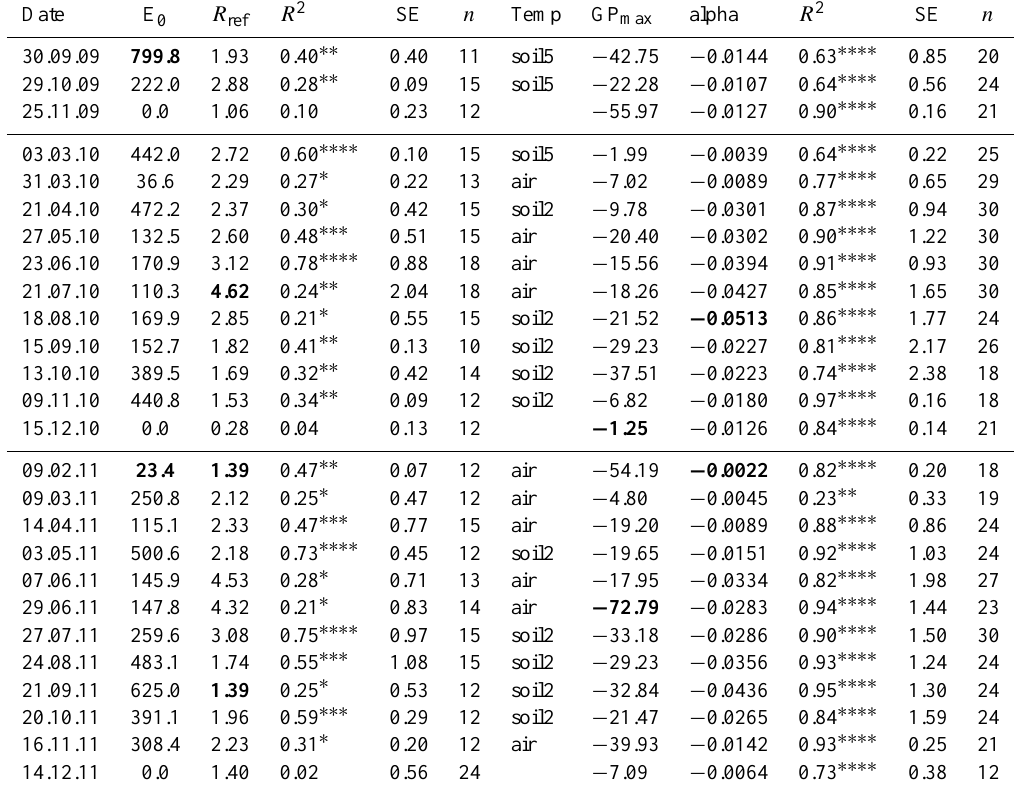
Table 4. Parameters for the R eco and NEE models of “ Eriophorum ”; E 0 : activation energy such as parameter [K]; R ref : respiration at the reference temperature [µmolCO 2 -Cm − 2 s − 1 ]; temp: best fit temperature for R eco model. GP max : maximum rate of carbon fixation at PAR (Pearson) between modelled and measured values. SE: standard error of the model [µmolCO 2 -Cm − 2 s − 1 ]; n : number of samples. Max. and min. values are printed in bold. Eventually measurement campaigns were pooled together.